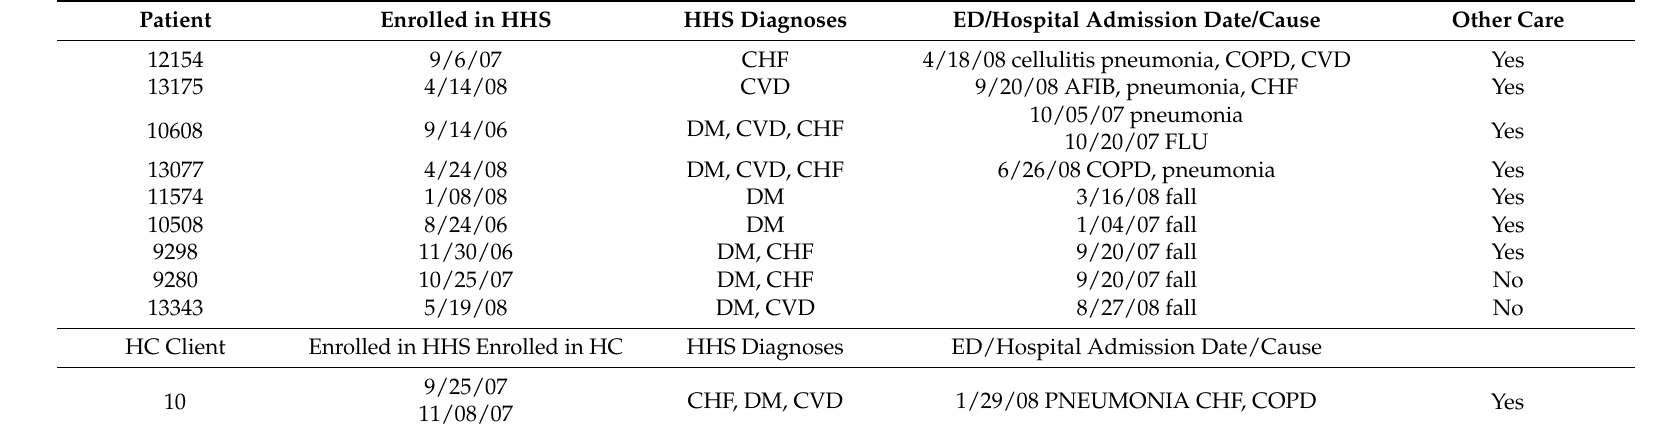
Table 6. Emergent Care for Pneumonia, Flu and Falls—Comparison Patients and HC